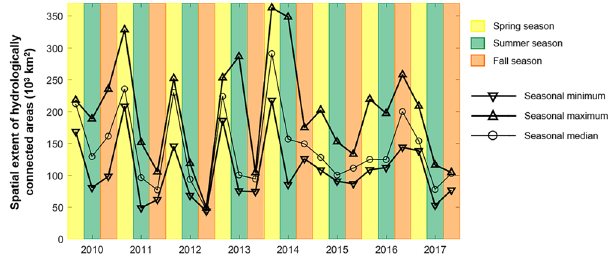
Figure 4. Seasonality effects on connectivity. Changes in the minimum, maximum and median spatial extent of hydrologically connected areas in the Lake Winnipeg Watershed across the spring, summer and fall seasons during the 2010–2017 period. The plots were created using MATLAB (version R2016a, www.mathworks.com).